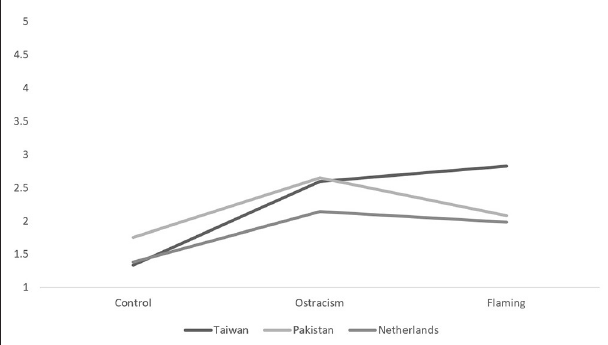
FIGURE 1 | The between-subjects interaction between nationality and trolling type for anger.